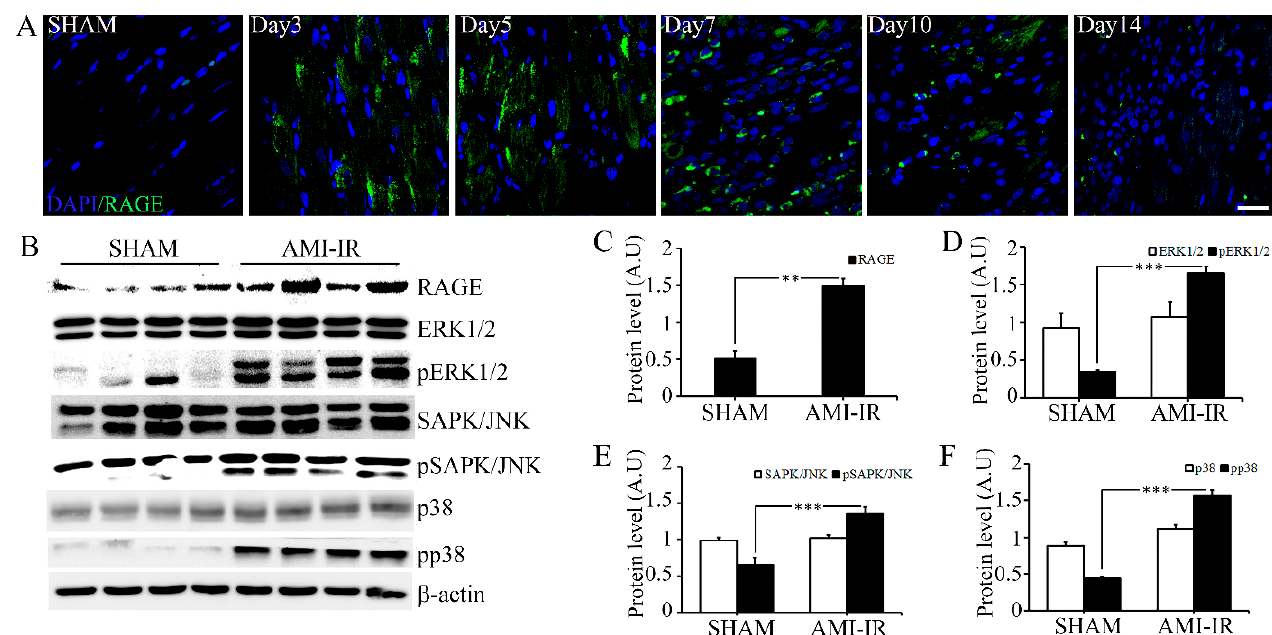
Figure 4. The relative level of RAGE and MAPKs in ischemic reperfusion injured rat heart. ( A ) RAGE expression is shown in double-labeled confocal images: RAGE (green) and DAPI (blue) in the left ventricle of sham and ischemic reperfusion injured hearts of rats at day 3, 5, 7, 10, and 14 in the border area. ( B ) Immunoblot analysis was performed to determine the expressed levels of RAGE, ERK1/2, p38, SAPK/JNK, pERK1/2, pp38, pSAPK/JNK, and β -actin, used as internal controls for equal protein loading of each lane. ( C – F ) Densitometry analyses of MAPK proteins were evaluated using the Image-J software. Scale bar = 50 µ m; **, p < 0.01; ***, p < 0.001.